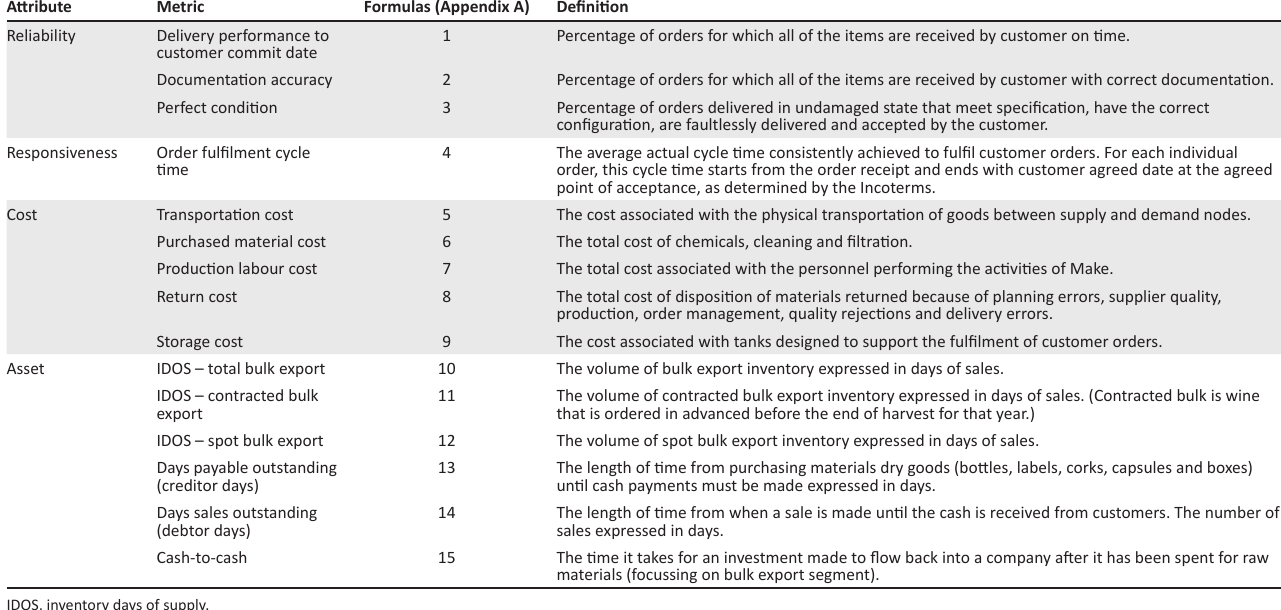
TABLE 3: Metric definitions: Ideal framework – bulk export (metric formulas in Table 1-A1). Attribute